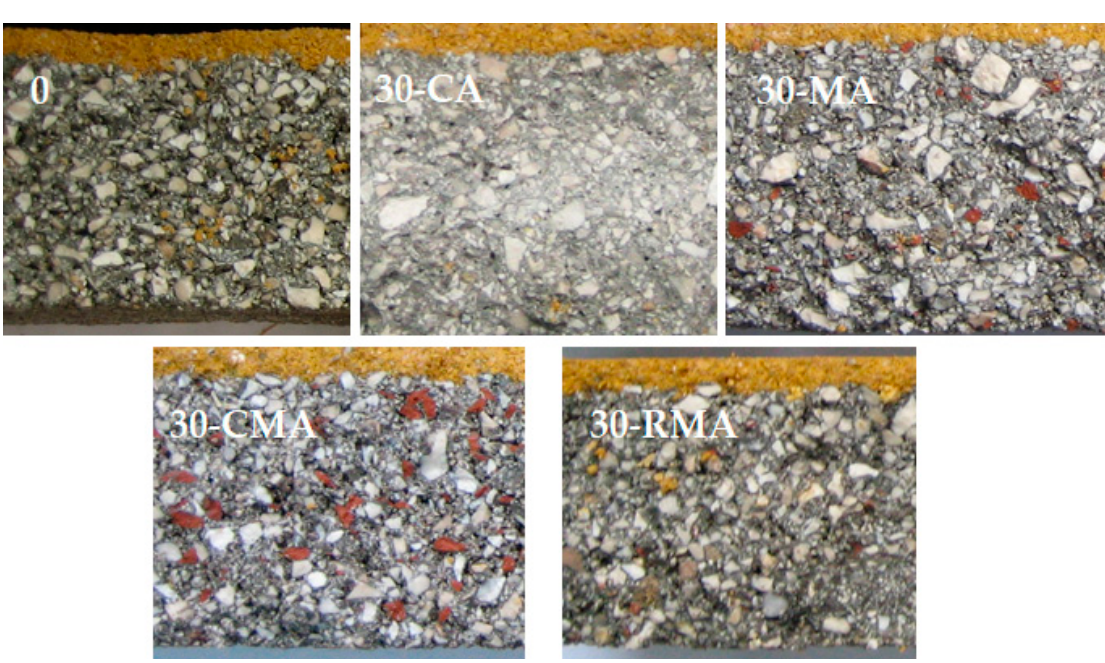
Figure 3. Paving blocks photographs for the different types of the recycled aggregates used.